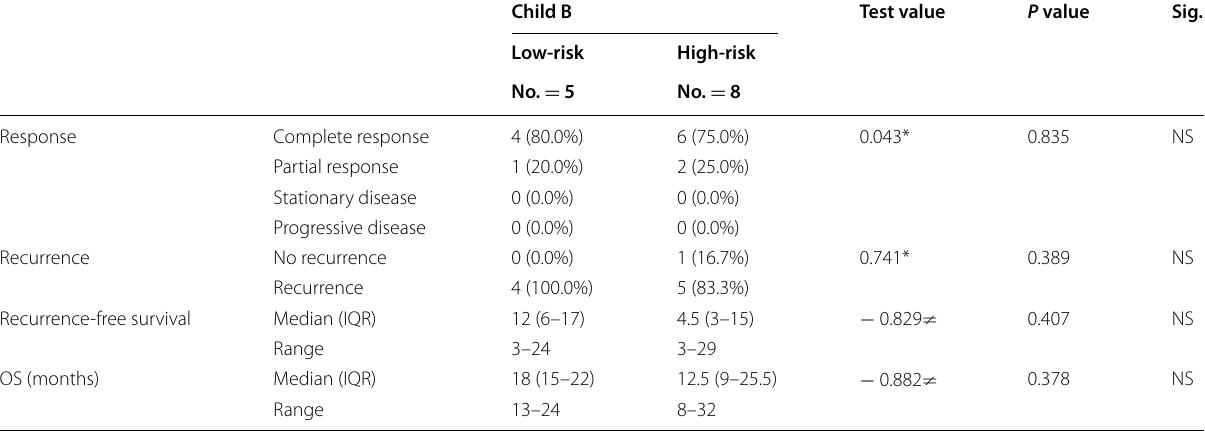
Table 8 Classifying Child B cases into low- and high-risk groups for TACE according to the AFP